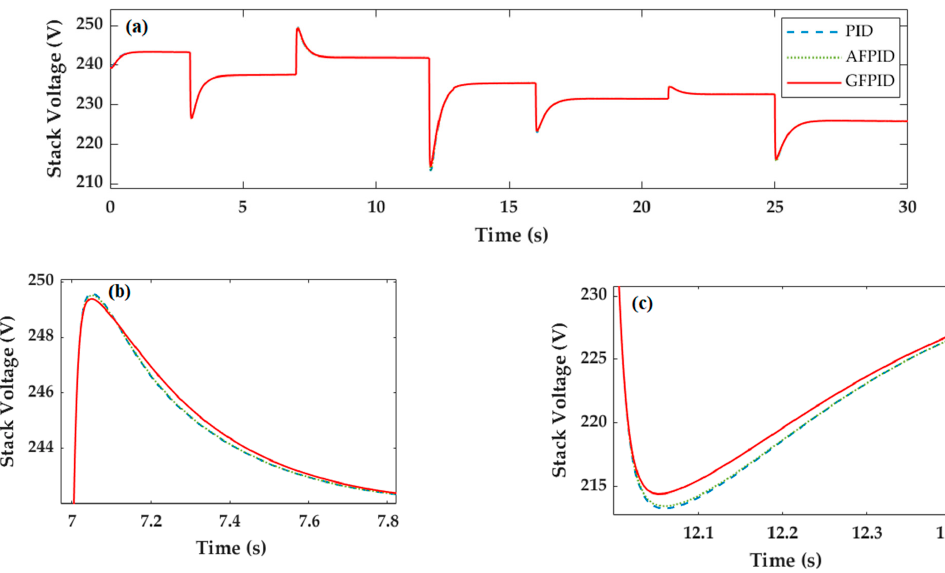
Figure 15. PEMFC parameters: ( a ) 30 s of stack voltage; ( b ) stack voltage at 7 s; ( c ) stack voltage at